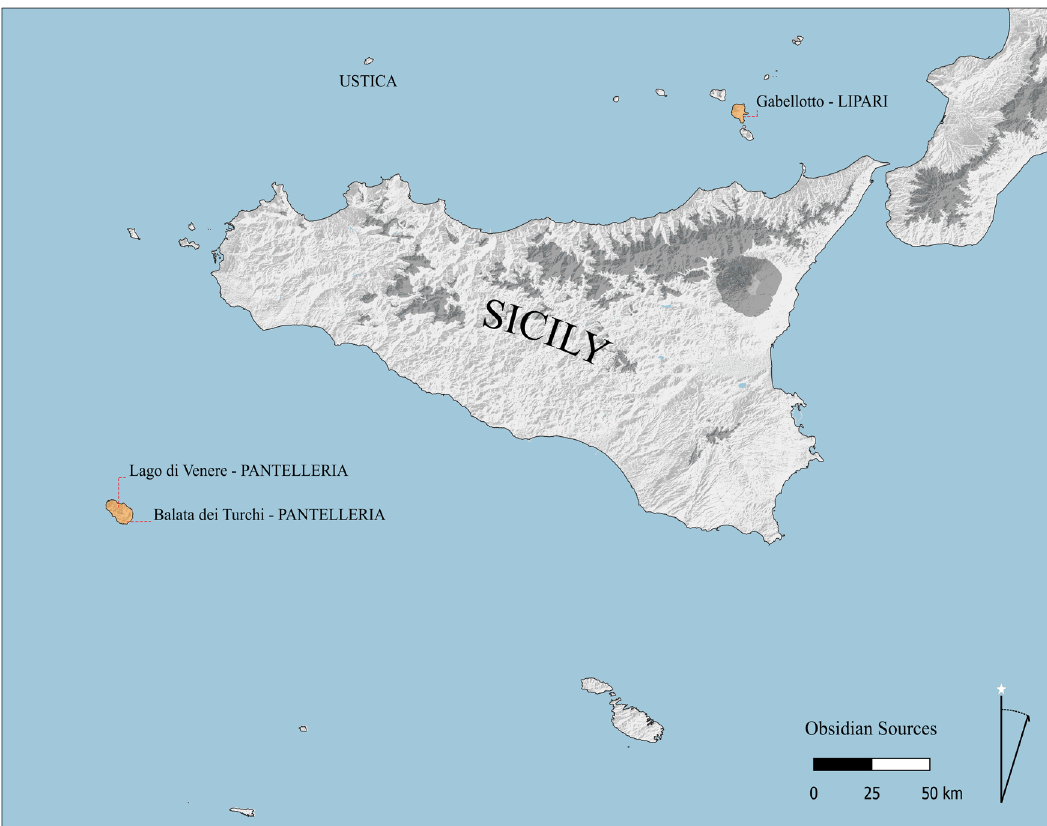
Figure 8: Position of the obsidian sources in Southern